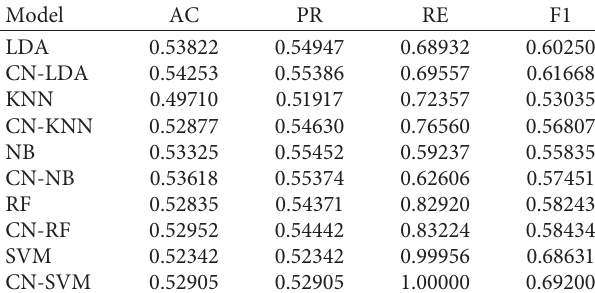
Table 3: The results of the average prediction accuracy.